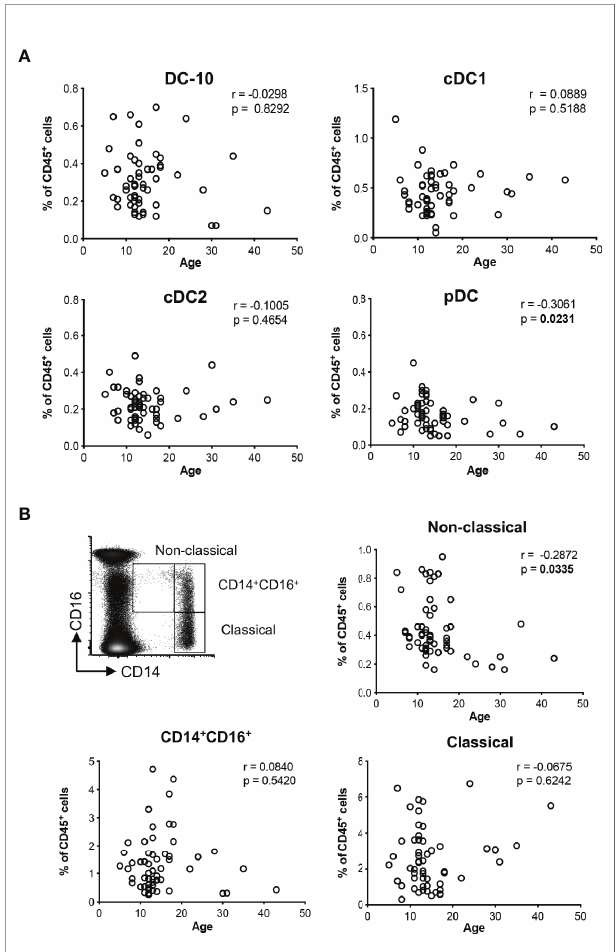
FIGURE 1 | Distributions of the major dendritic cell and monocyte subsets with age. The percentage of DC-10 (CD11c + CD14 + CD16 + CD141 + CD163 + ), cDC1 (CD11c + CD14 − CD141 + ), cDC2 (CD11c + CD1c + ), and pDC (CD11c − CD303 + ), and CD14 + CD16 + , and non-classical (CD14 low CD16 + , and classical (CD14 high CD16 − ) monocytes were evaluated by multiparametric fl ow cytometry in the peripheral blood of healthy donors (HCs) at different ages. Scatterplot and Spearman ’ s correlation analyses between age and the indicated DC populations (A) and monocyte subsets (B) are shown. Each data point represents a donor (n = 55). Data distribution, Spearman ’ s rank correlation coef fi cient (r), and p-values are shown for each analysis. Statistically signi fi cant p-values are indicated in